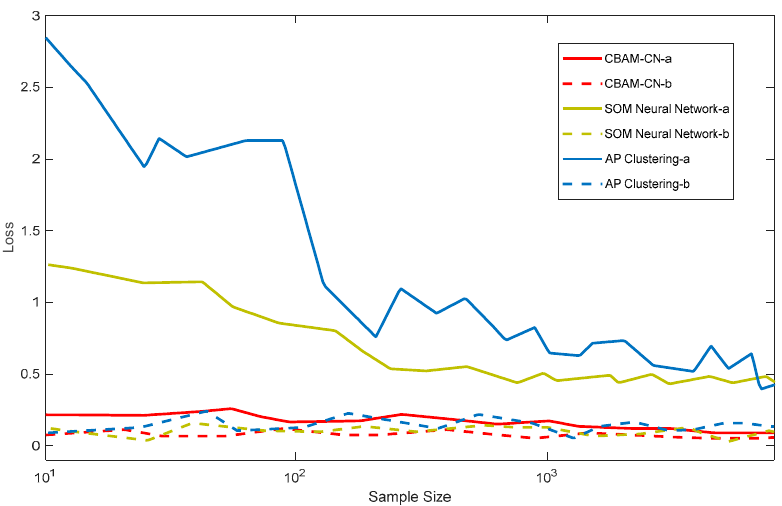
Figure 12. The relationship between the loss and the number of samples.